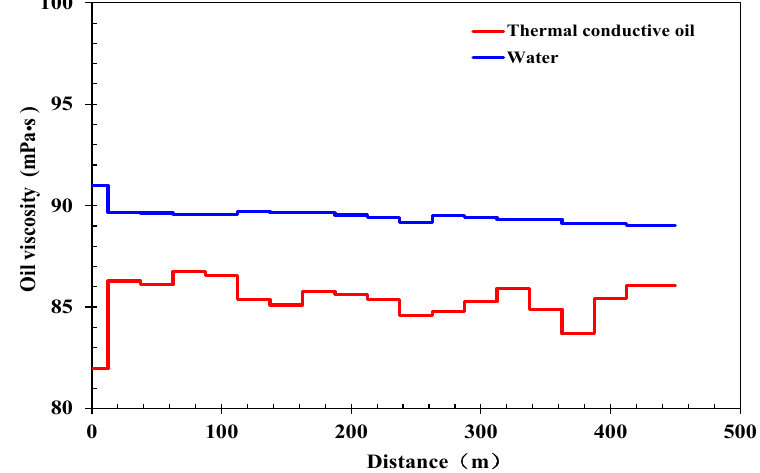
Figure 10. Oil viscosity between injection and production well.